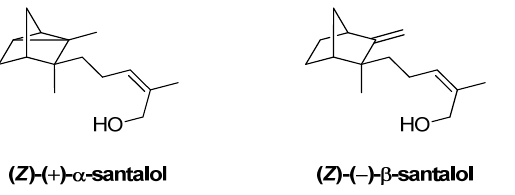
Figure 4. Isomers of santalol, the main impact odorants of sandalwood essential